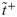
Adjustment of learning to reward probability in the superior metaplastic models.(a) Plotted are the effective learning rates for potentiation (t˜+) and depression (t˜−) events as a function of pr. The effective learning rate on potentiation (depression) events increases (decreases) as reward probability increases, with a crossover at pr = 0.5. (b) Signal in superior metaplastic models. (c) Matching of the sensitivity to noise in the metaplastic models. Plotted are the normalized sensitivity (dS/dpr, denoted as (ΔS)norm) and one-step noise (η) as a function of pr for three examples of superior metaplastic models with different numbers of meta-states. The sensitivity profile better matches the noise profile as N increases.